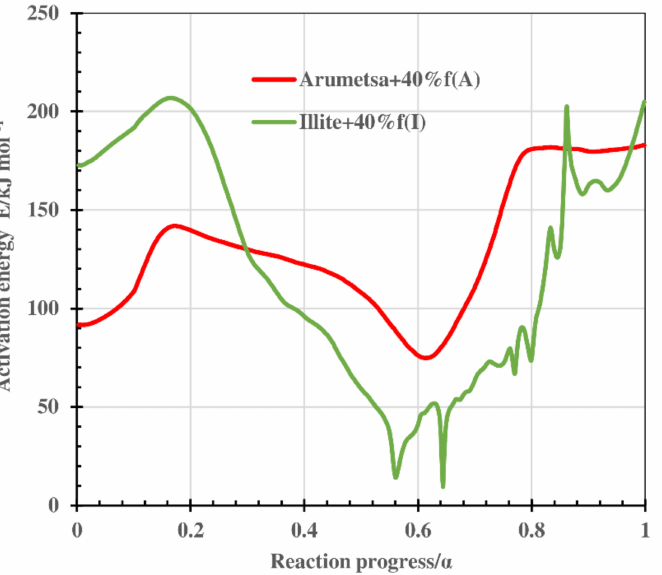
Figure 9. Value of the activation energy E determined by Friedman analysis as a function of the conversion degree α for thermooxidative decomposition of Arumetsa and illitic clay with 40% grog. For example, the value of the activation energy E for the Arumetsa as well as